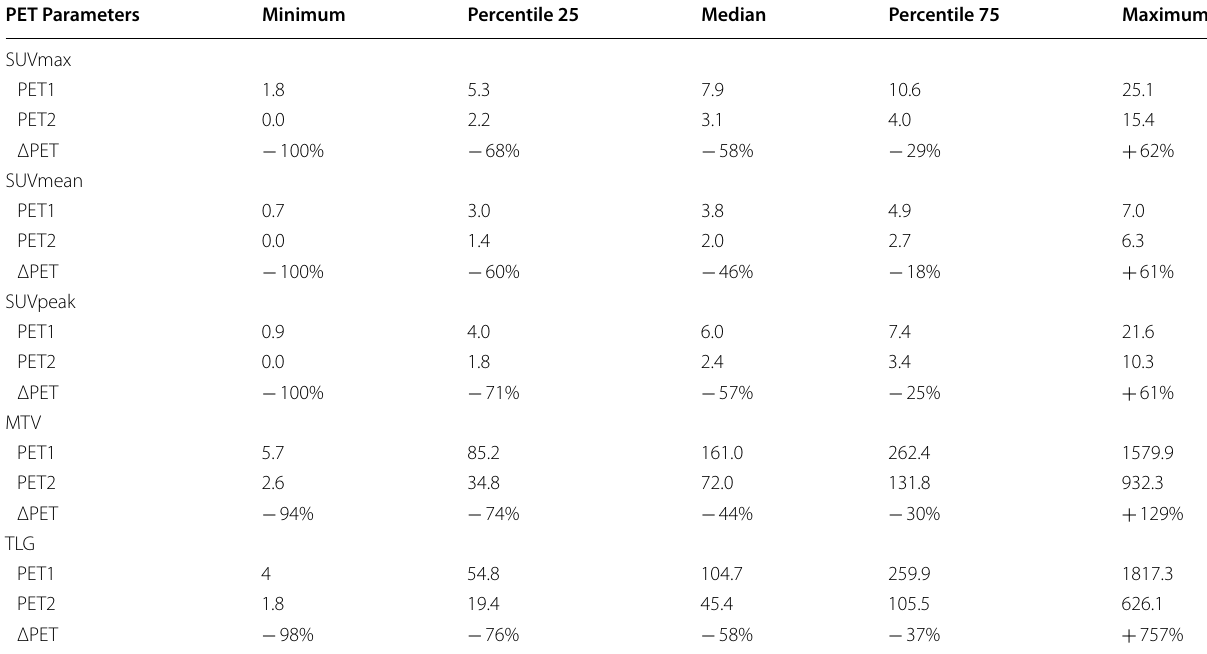
Table 2 [ 18 F]FDG PET parameters (SUVmax, SUVmean, SUVpeak, MTV and TLG) at PET1, PET2 and their changes PET